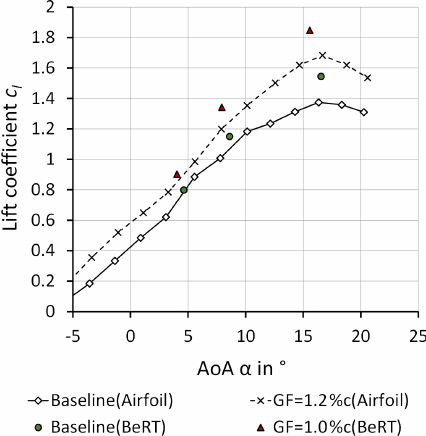
Figure 11. Lift coefficients of the Clark-Y airfoil including Gurney flap, reproduced and modified from Kheir-Aldeen